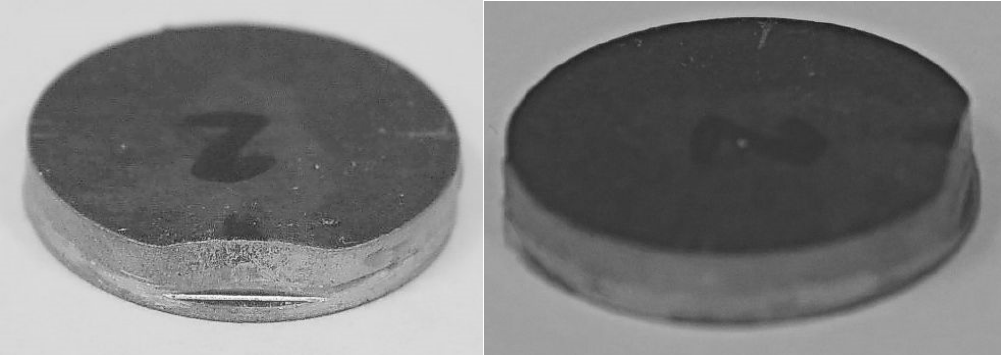
Figure 7. Top parts of the specimens after the impact strength tests.